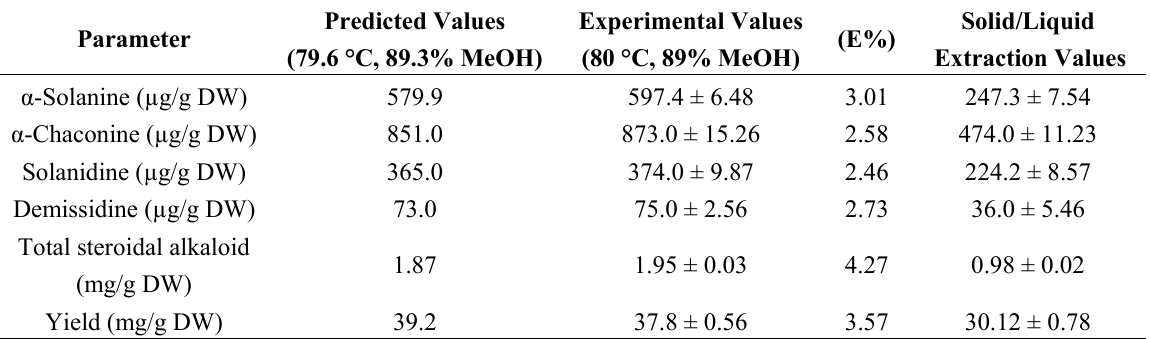
Table 3. Predicted and experimental values of the parameters tested at optimal PLE condition in comparison to the conventional solid/liquid extraction values and average mean deviation between predicted and experimental values of optimal PLE (80 °C and 89%